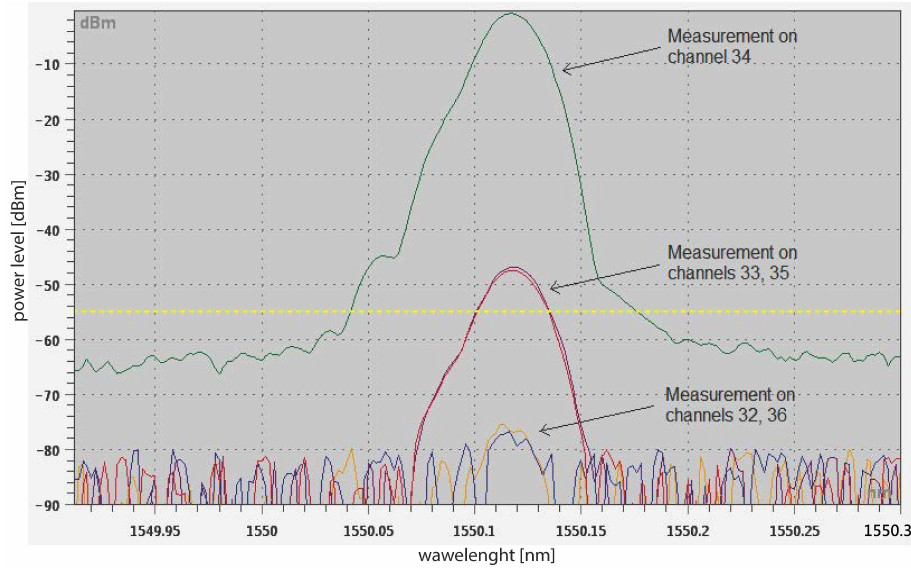
Figure 9. Channel crosstalk of AWG DWDM MUX.